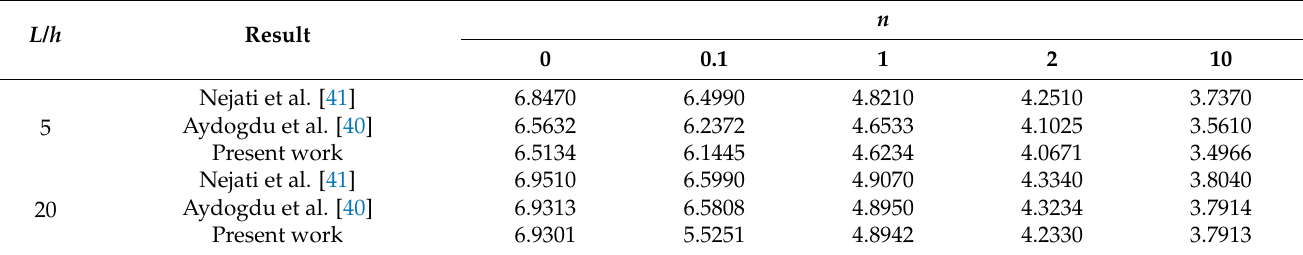
Figure 2. Variation of the critical temperature versus h / L for two types of thermal distribution. Table 5. First dimensionless frequency for FGM beam with an S-S boundary